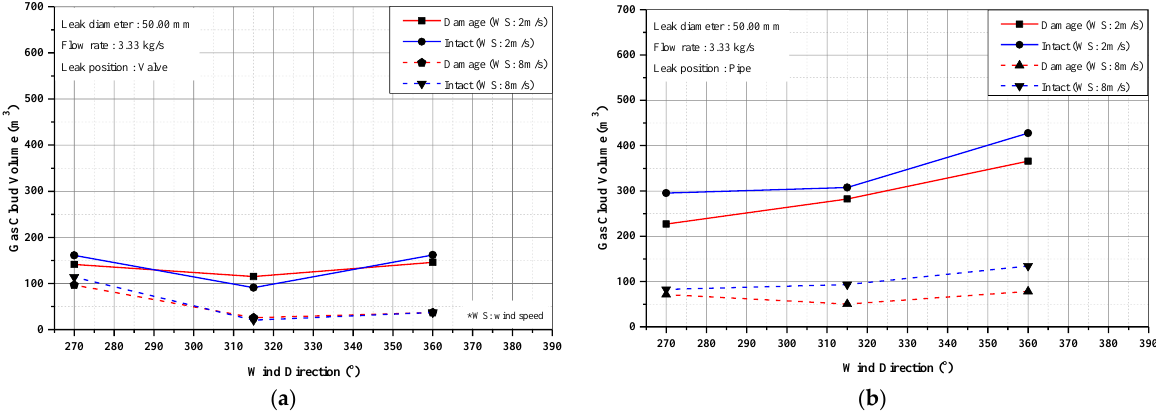
Figure 18. Plots of gas cloud volume with respect to wind direction: release in valve ( a ) and release in the pipe ( b ).